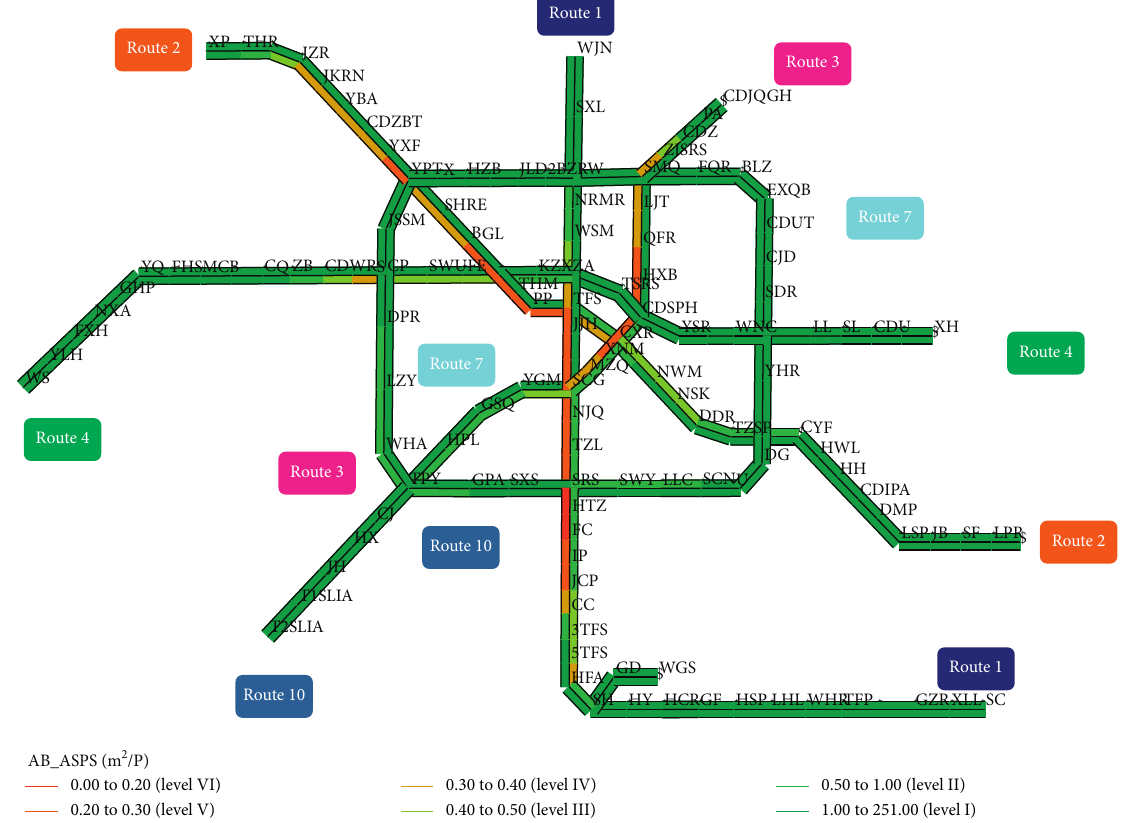
Figure 11: Average space per standee (8:00–9:00 of a train profile represents the load factor on each link. The congestion level of each train is illustrated in a space-time diagram, in which the red segments with high load factors appeared during AM and PM peaks.